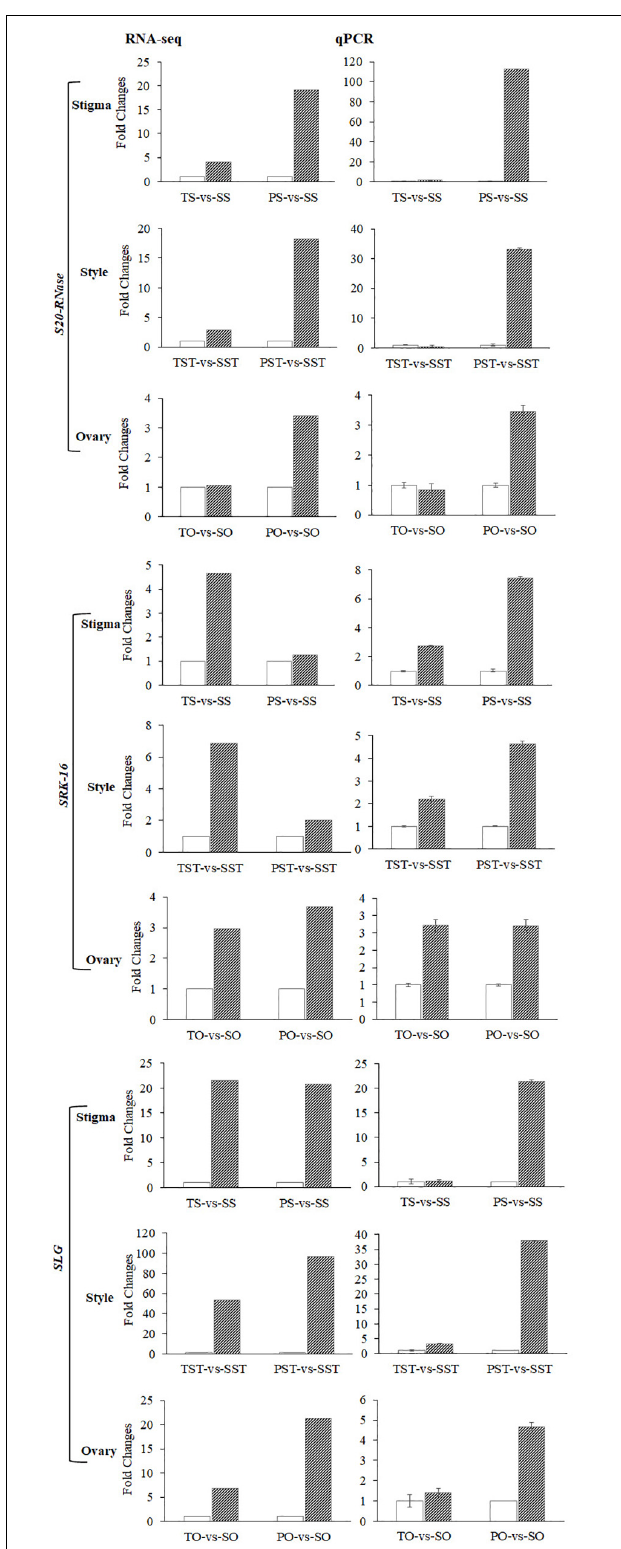
FIGURE 7 | Expression changes of S20-RNase , SRK-16 , and SLG genes revealed by RNA-seq and